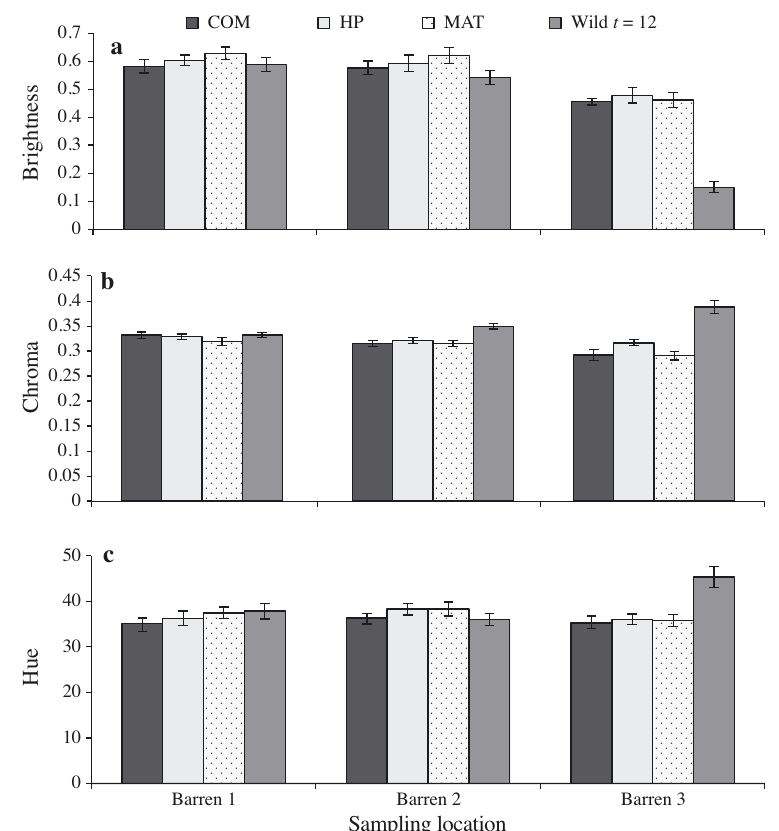
Fig. 4. Expt 2: Mean ± SE gonad colour between purple urchins from 3 urchin barrens in Port Phillip Bay, Victoria. These urchins were fed 1 of 3 pellet diets for 12 wk: a commercially available diet (COM; dark grey bars), a high-protein diet (HP; light grey bars) and a diet which had the same pro- tein level as the commercial diet but was made with different ingredients (MAT; dotted bars) or were collected from the wild (Wild t = 12; medium grey bars). The colour of each gonad was assessed in terms of its (a) bright- ness, (b) chroma and (c)